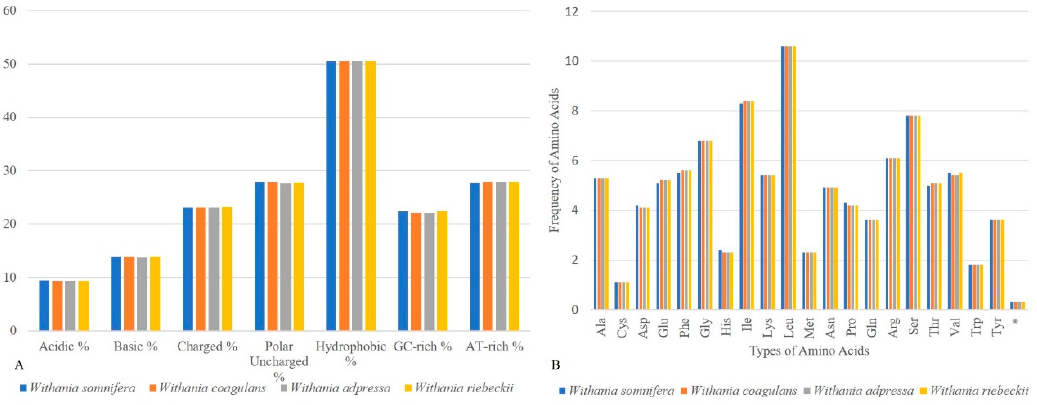
Figure 3. ( A ) Assessment of amino-acid groups and ( B ) amino-acid frequency comparison among Withania species . Table 1. Summary of Withania chloroplast genome features.